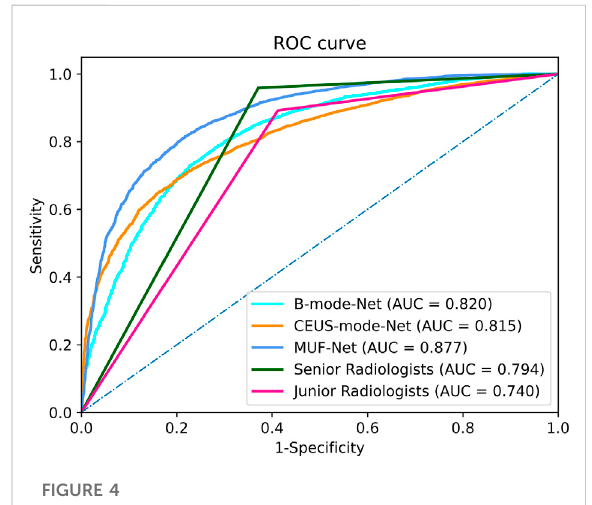
FIGURE 4 The receiver operating characteristic curves of the MUF-Net, single-mode models, and radiologists ’ assessments in the test